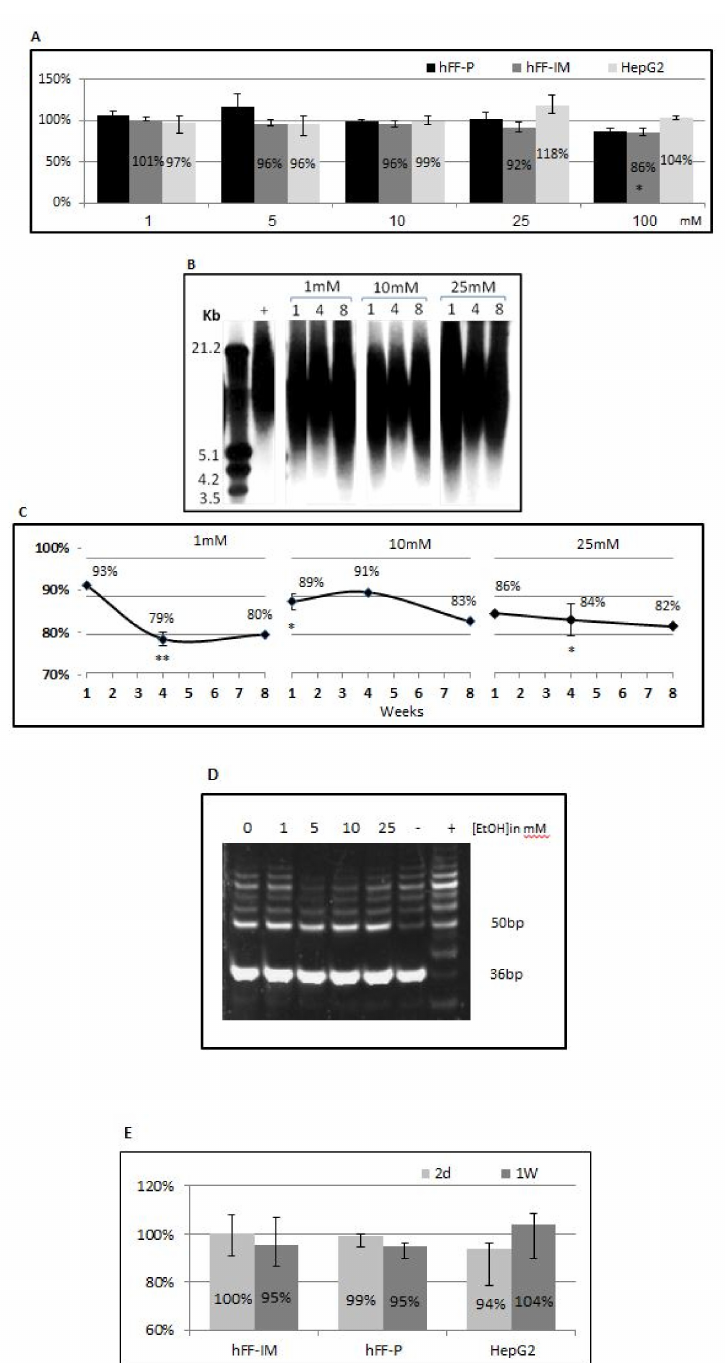
Figure 1. Cell viability and telomere length of various cell lines after treatment with EtOH. ( A ) Three cell lines, hFF-p, hFF-IM and HEPG2, were exposed to 1–100 mM EtOH for six days and their proliferation was measured by Wst-1 assay. Percentages represent values relative to the untreated control of each cell line. hFF cells were treated with 1, 10 and 25 mM EtOH for one, four and eight weeks and their telomeres were measured by Southern blot. ( B ) A representative example of Southern blot with DNA isolated from pHFF cell samples. +depicts TL of control untreated cells. ( C ) Quantitation of the Southern blot results showing the mean TRF values of treated vs. untreated. * pV < 0.05; ** pV< 0.01. ( D ) TA of hFF-IM cells in response to EtOH exposure: hFF-IM cells were treated with 1–25 mM EtOH for two days or one week and their TA was measured by the TRAP assay, A representative TRAP assay example. ( E ) TA of all three cell lines in response to EtOH exposure. pV <